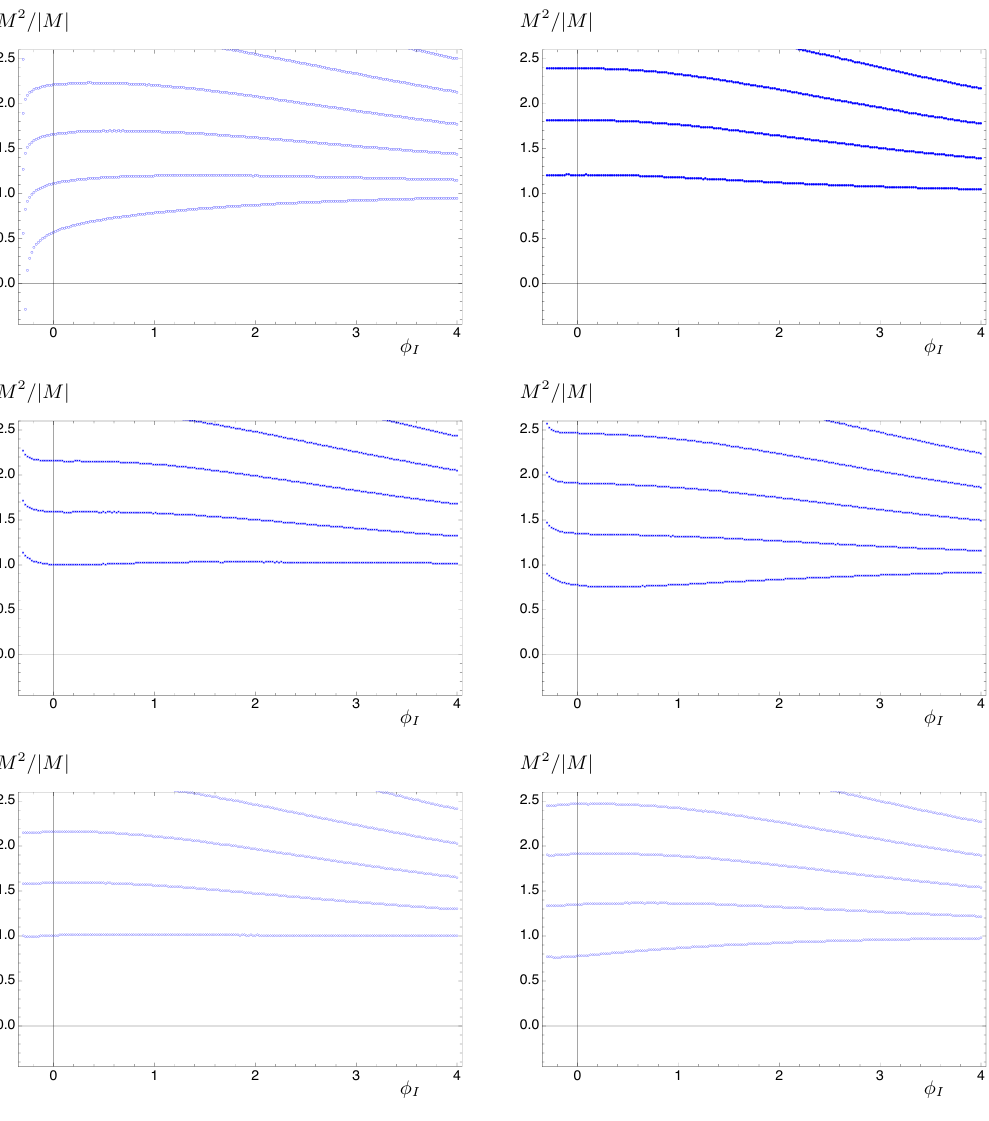
Figure 4 . Mass spectrum, with M 2 = − q 2 , of fluctuations of the scalar fields that vanish on the backgrounds, as a function of the parameter φ . The masses are expressed in units of the lightest I tensor mode in the spectrum. The markers are chosen to match the representations under SO(4)